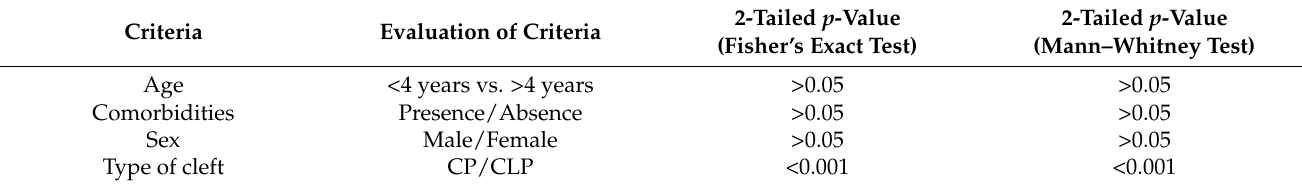
Table 2. Summary of the tested hypotheses regarding the number of secondary palatal surgical interventions.